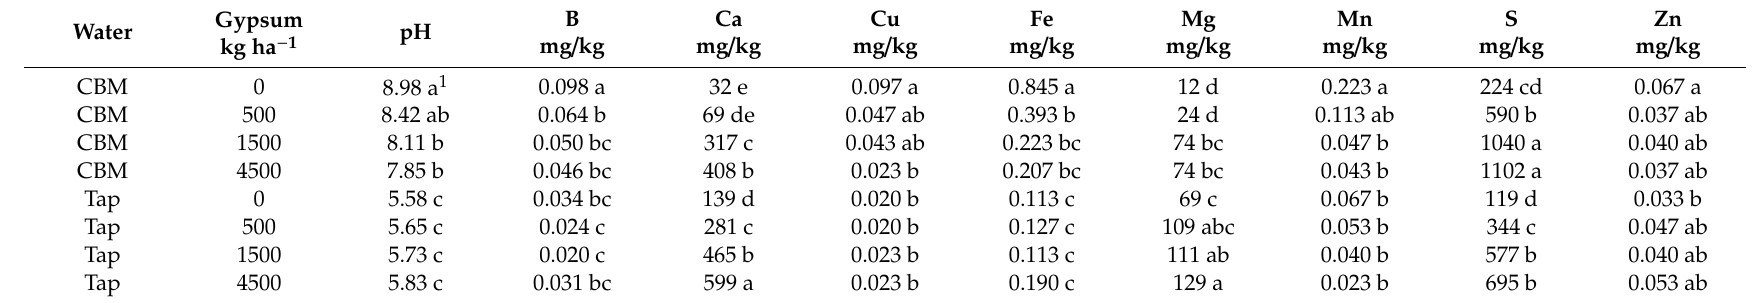
Table 10. Mean growth medium pH and available nutrients [boron (B), calcium (Ca), copper (Cu), iron (Fe), magnesium (Mg), manganese (Mn), sulfur (S), and zinc (Zn)] obtained from the eight combinations of water (coal-bed methane and tap) and gypsum application in the palmarosa experiment.